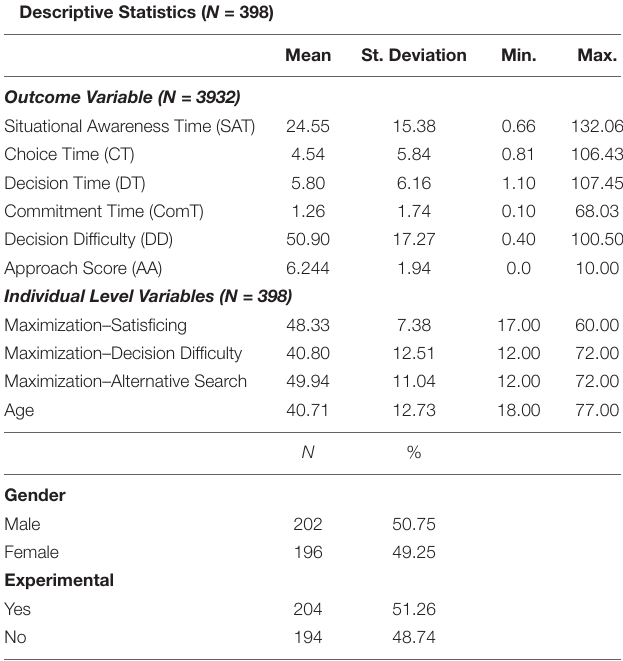
TABLE 1 | Descriptive statistics for participants ( N = 398). TABLE 2 | Group differences for performance between control and experimental